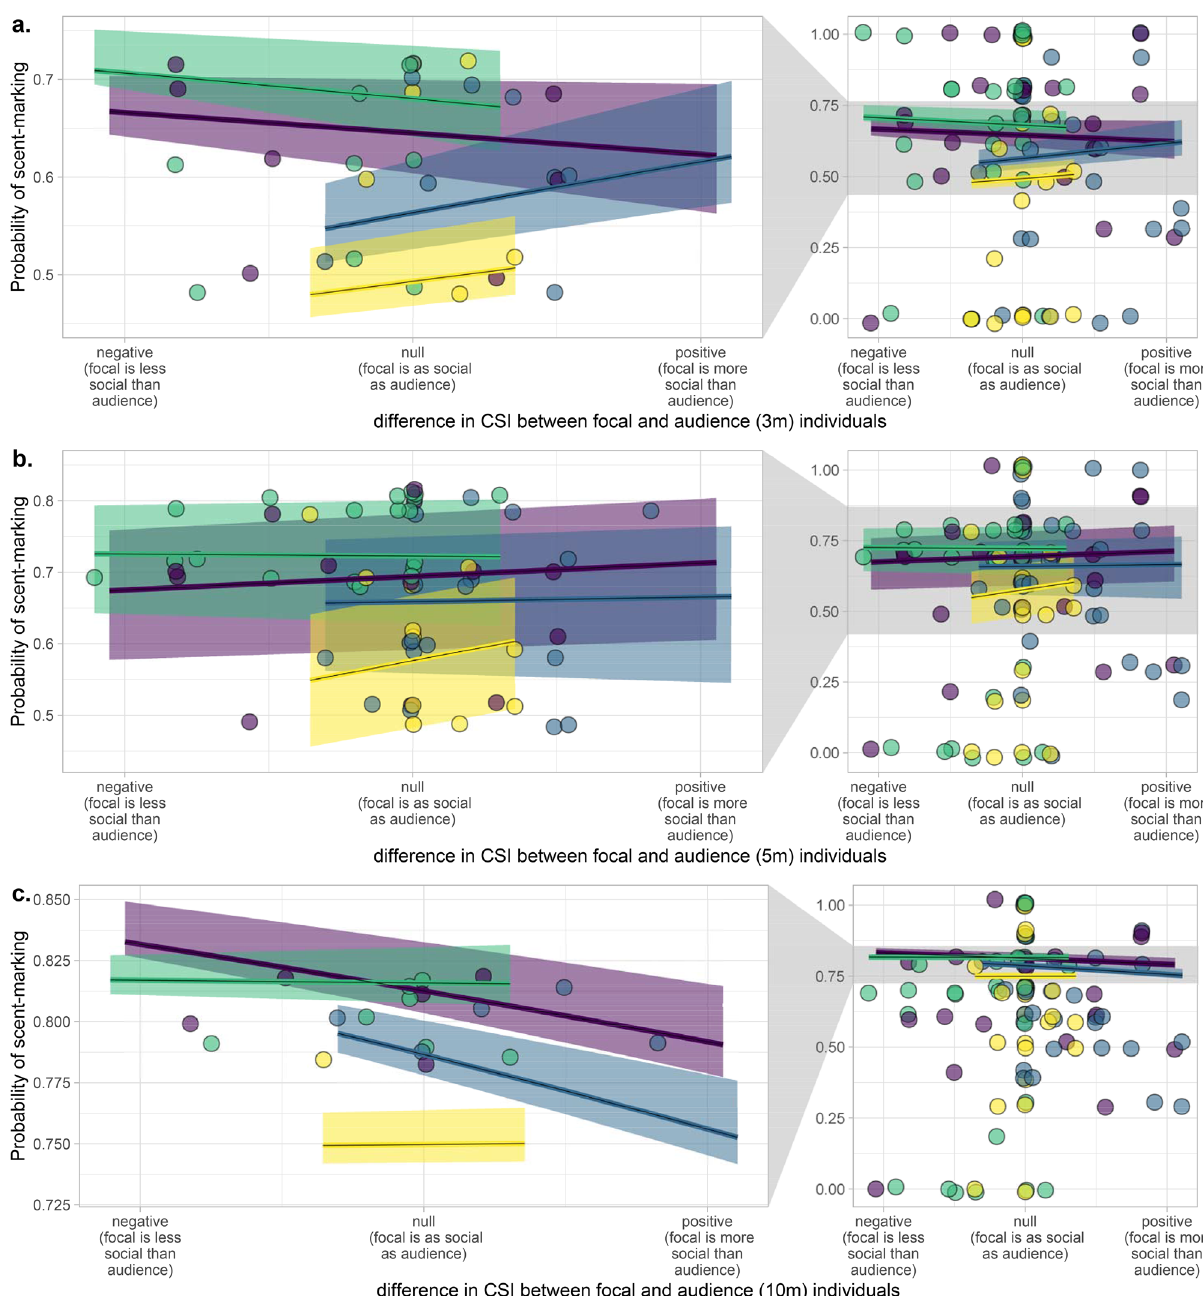
Figure 3. Probability to scent-mark as a function of the difference in CSI of the dyad for an audience ( a ) in a 3 m radius, ( b ) in a 5 m radius, and ( c ) in a 10 m radius. The shaded areas show 95% confidence intervals of the model (conditional on the number of observations being at its average and on a group effect weighted by the number of individuals in each group). The first column of plots presents the zoomed-in section of the full range, indicated by grey polygons, to better depict the corresponding regression lines. This figure was visualized and edited using R (https:// www.r- proje ct.